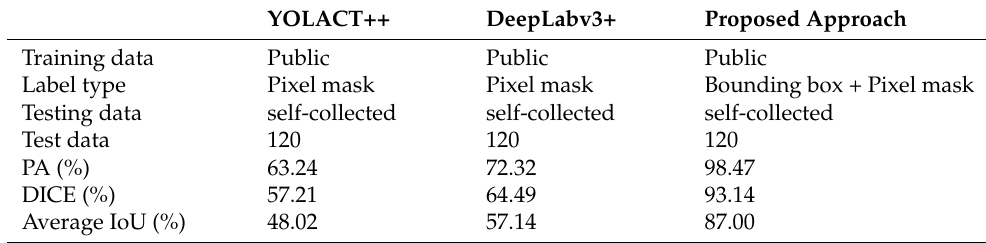
Figure 13. Comparisons of the proposed approach, YOLACT++, and DeepLabv3+ for segmenting cracks from images with complex backgrounds. Table 3. The information of the three methods and the comparison of the evaluation